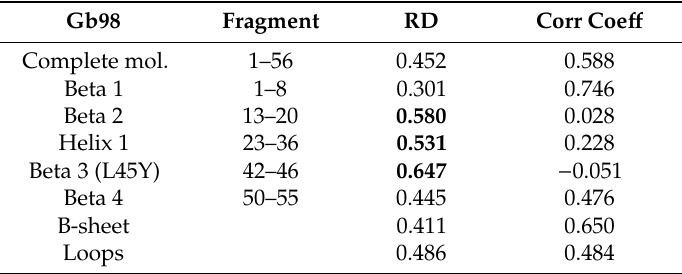
secondary structure: Hexagons— α -helices, squares— β -strands. White circles mark the location of hydrophobic core as determined by the FOD model. Gray-shaded regions encompass contiguous sequence fragments containing this core (combined with Gb98-T25I,L20A core data). Orange star locates the mutation (L45Y). ( B ) theoretical and observed hydrophobicity density scatter plot. Red shade—hydrophobic core zone, blue shade—hydrophilic surface zone. Markers denote the same residues as markers on A, except for small dark gray circles which are hydrophobicity parameters of unstructured fragments. Dashed line—Theoretical and observed value equality line. Dotted lines—theoretical and observed value similarity threshold. ( C ) 3D presentation of the molecule. Secondary structures are distinguished using the same colors as on A. Hydrophobic core fragments are shown as white sticks, while mutation as orange spheres. Table 3. List of parameters characterizing the status of the entire Gb98 protein and the highlighted sections representing a specific secondary structure. Bold— RD status di ff erent from idealized (discordant fragment). Gb98 Fragment RD Corr Coe ff Complete